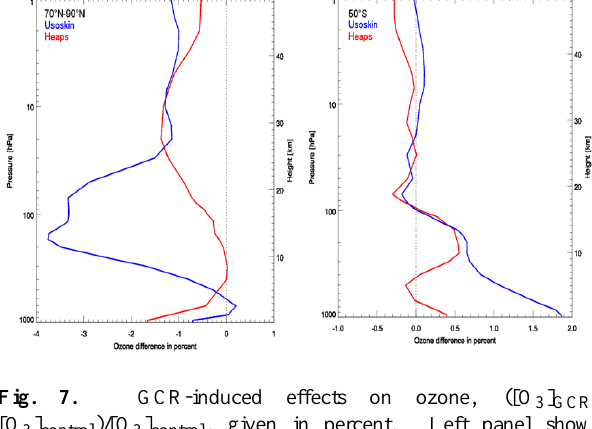
Fig. 7. GCR-induced effects on ozone, ([O 3 ] GCR - [O 3 ] control )/[O 3 ] control , given in percent. Left panel shows the annual mean averaged for 70 ◦ –90 ◦ N and for 50 ◦ S (right). Red line: parameterization by Heaps (1976). Blue line: param- eterization by Usoskin et al. (2010). Results are averaged from 1978–2002 (all seasons, after allowing for a 2-year model spin-up).